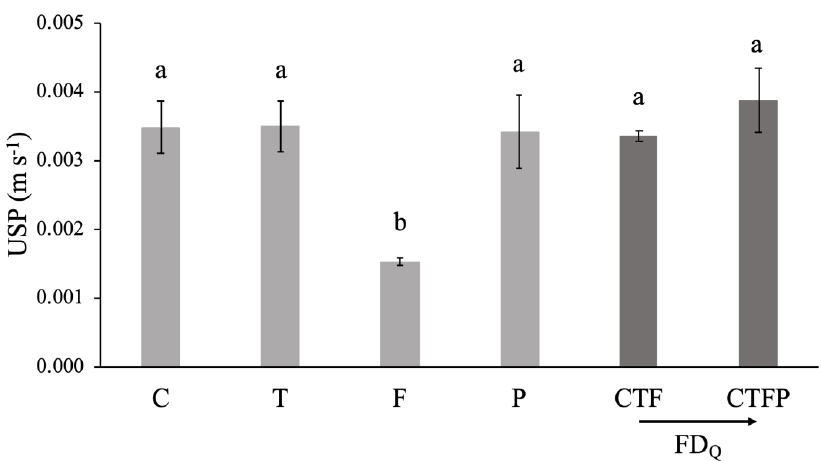
Figure 2. Differences between each community, at discharge 2 L s −1 m −1 . The bars represent the mean ± standard error. The letters represent the significant differences between each community according to the Tukey post-hoc tests. The arrow represents the increase of the functional diversity between both multi-specific conditions (with Rao’s quadratic entropy (FDQ)).